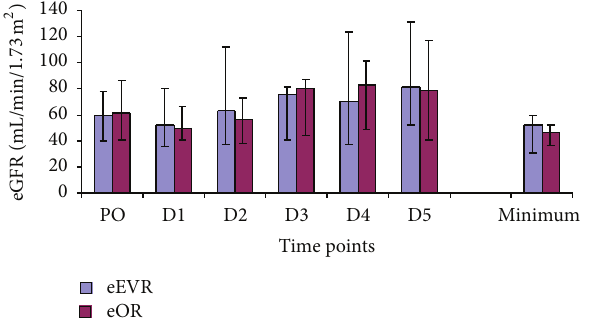
Figure 3: eGFR in the eEVAR versus eOR groups expressed as median and IQR (Mann-Whitney 𝑈